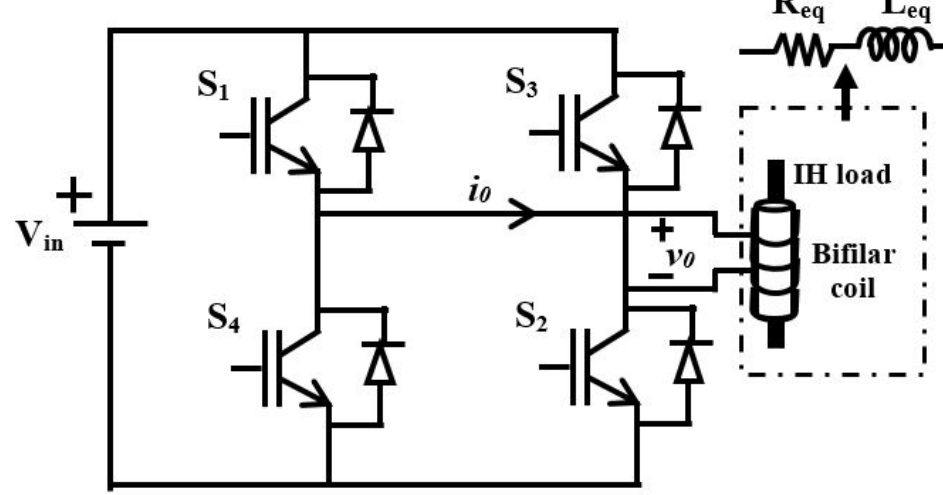
Figure 1. Circuit diagram of a full-bridge series-resonant